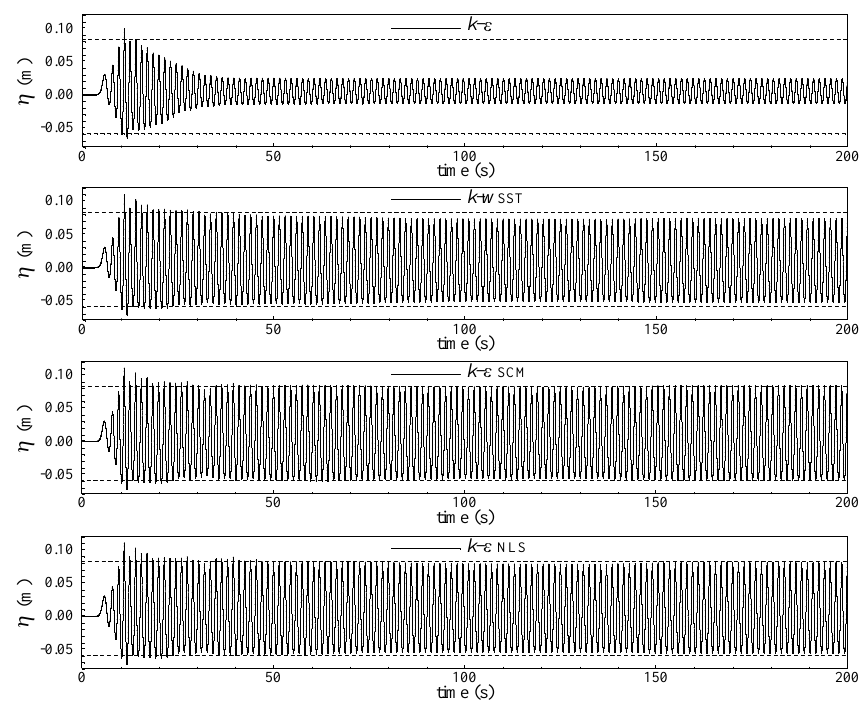
Figure 3. Time series of the free surface elevation in the middle of the wave flume for the wave propagation case for the four turbulence models — dash-lines indicate the mean wave crest and trough obtained by the k- ε NLS model.